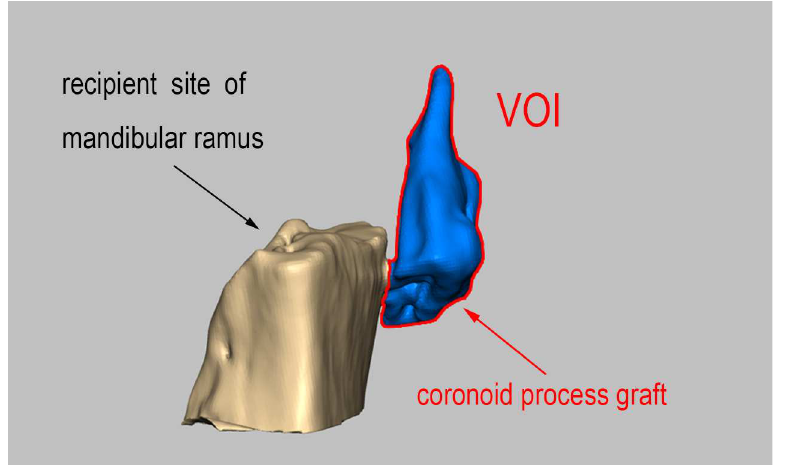
Fig 3. The volume of the coronoid process